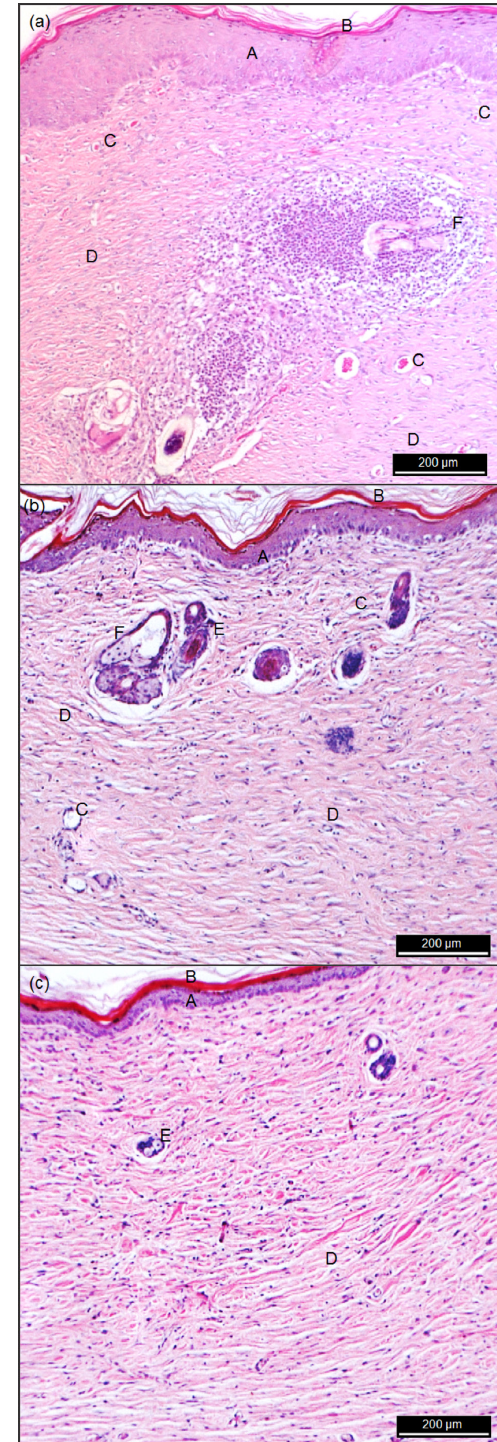
Figure 9. 30-day period, (a) – GI shows complete epithelium and dermis repair, keratin layer and hair follicle; (b) – GII shows complete epithelium and dermis repair with hair follicle and glands; (c) – GIII shows organized tissue, re-epithelialization, keratin layer and presence of glands. Epithelium (A), keratin layer (B), neovascularization (C), organization of collagen fibers (D), glands (E) and hair follicle (F). Staining: